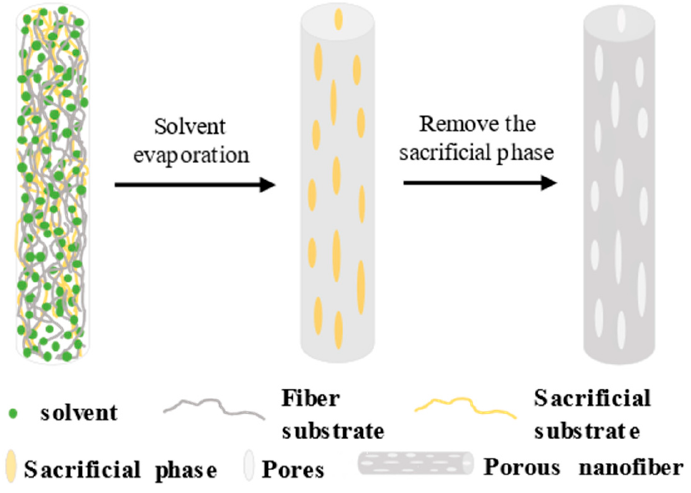
Figure 6. Schematic of the pore − forming mechanism of